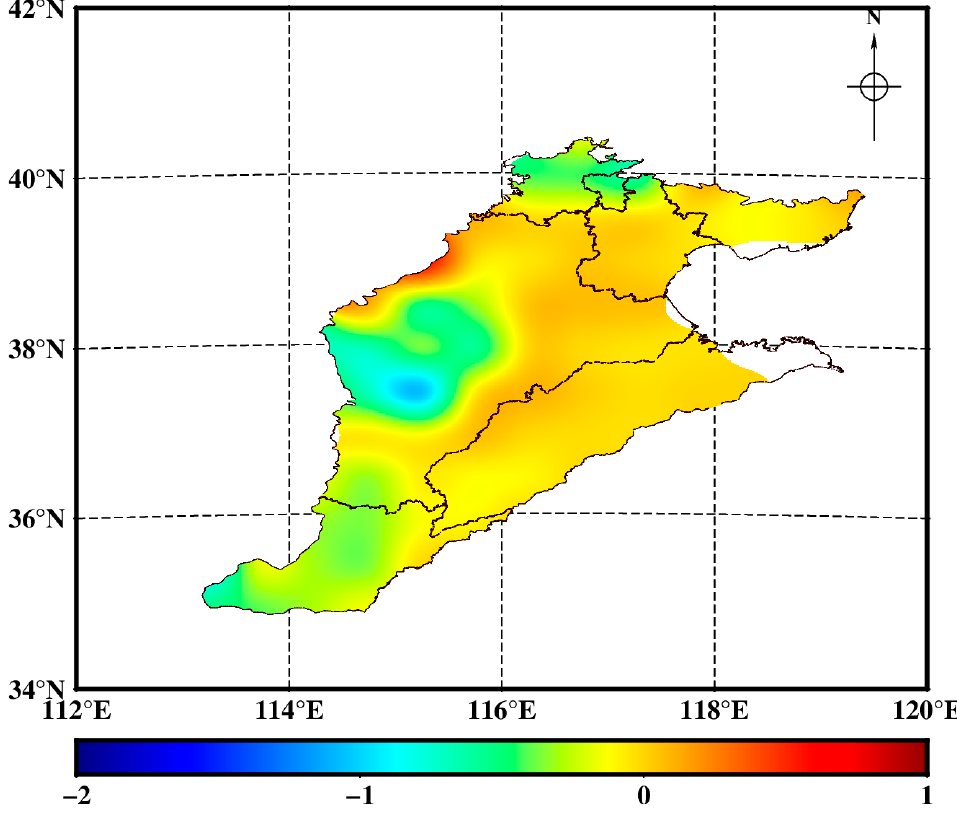
Figure 3. Groundwater storage trends observed by the unconfined wells during 2005 to 2018.